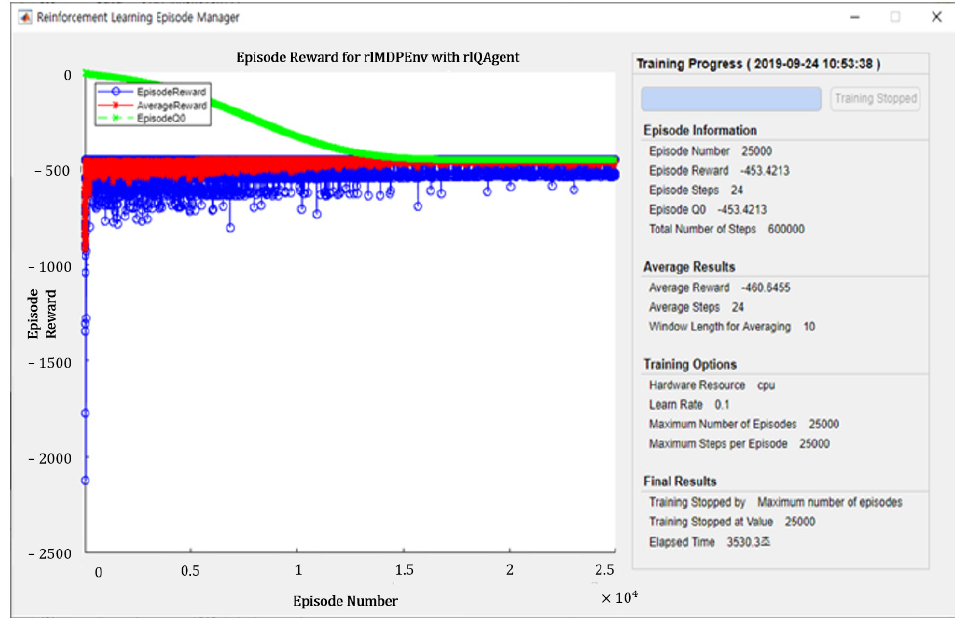
Figure 15. ( a ) The power system architecture; ( b ) The Load power curve and PV Output curve.